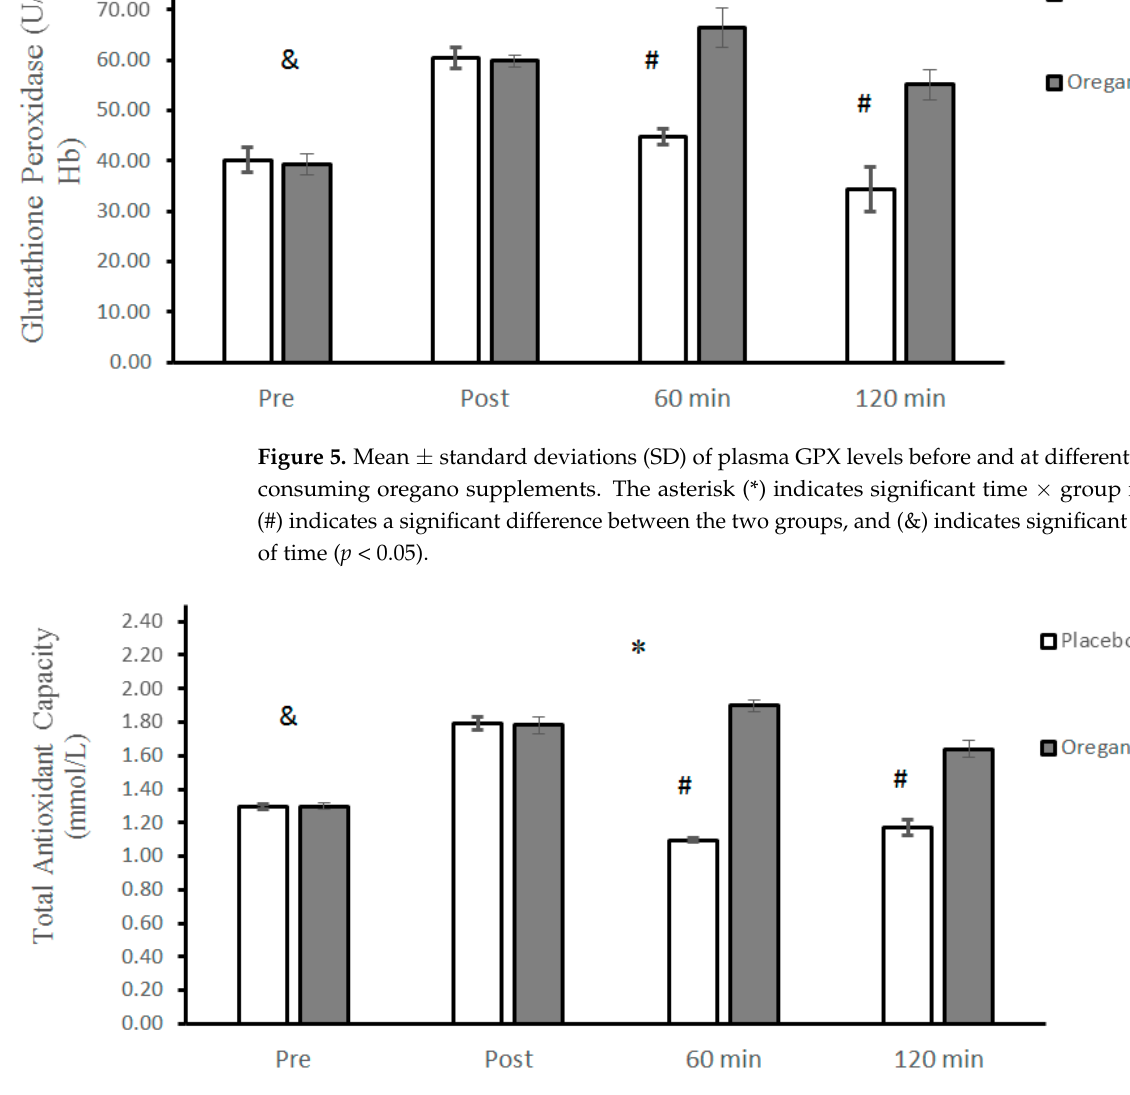
Figure 6. Mean ± standard deviations (SD) of plasma TAC levels before and at different times after consuming oregano supplements. The asterisk (*) indicates significant time × group interaction, (#) indicates a significant difference between the two groups, and (&) indicates the main effect of time ( p < 0.05).